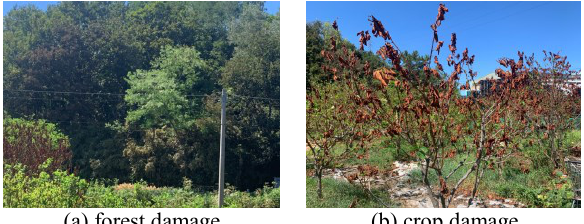
Figure 6 . Ground photos at chemical incident area